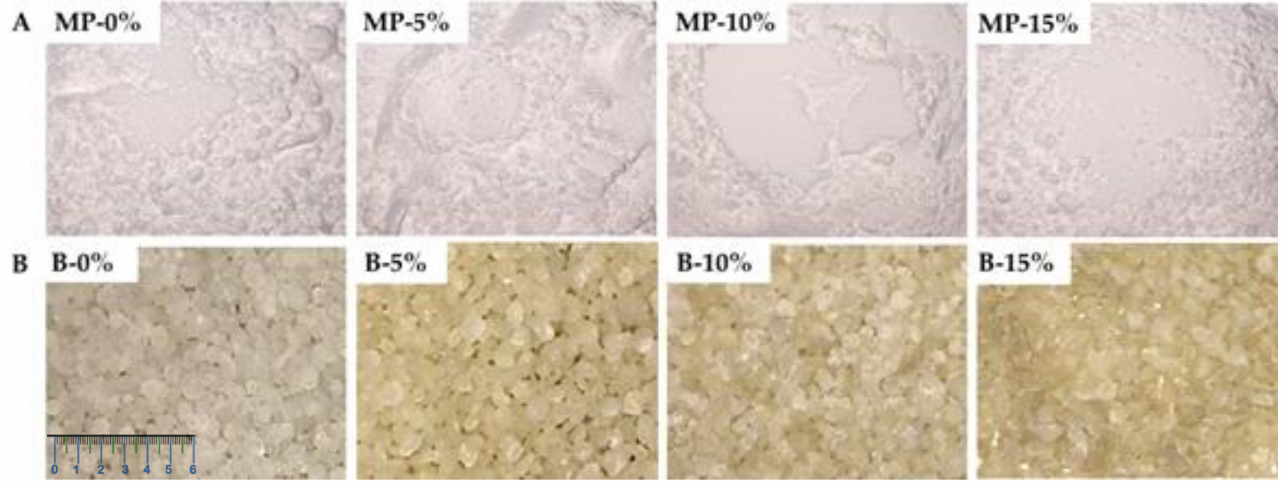
Figure 3. Macroscopic view of microparticles (MP) (A) and beads (B) at different concentrations of cochleates of S. Infantis (0–15%